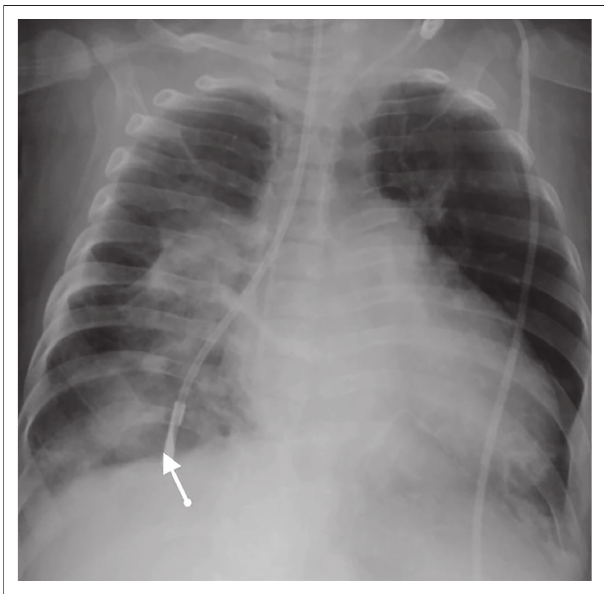
FIGURE 10: The nasogastric tube (NGT) (arrow) has entered the tracheobronchial tree, with the end lying within a terminal bronchiole of the right lower lobe. The surrounding lung changes are secondary to inadvertent administration of feeds into this NGT. Disconnection/fracture is the second most common cause of mechanical shunt failure. The neck and scalp are common sites. An X-ray shunt series (skull AP and Lateral, Chest AP, Abdomen AP views) can be done to determine the location of the